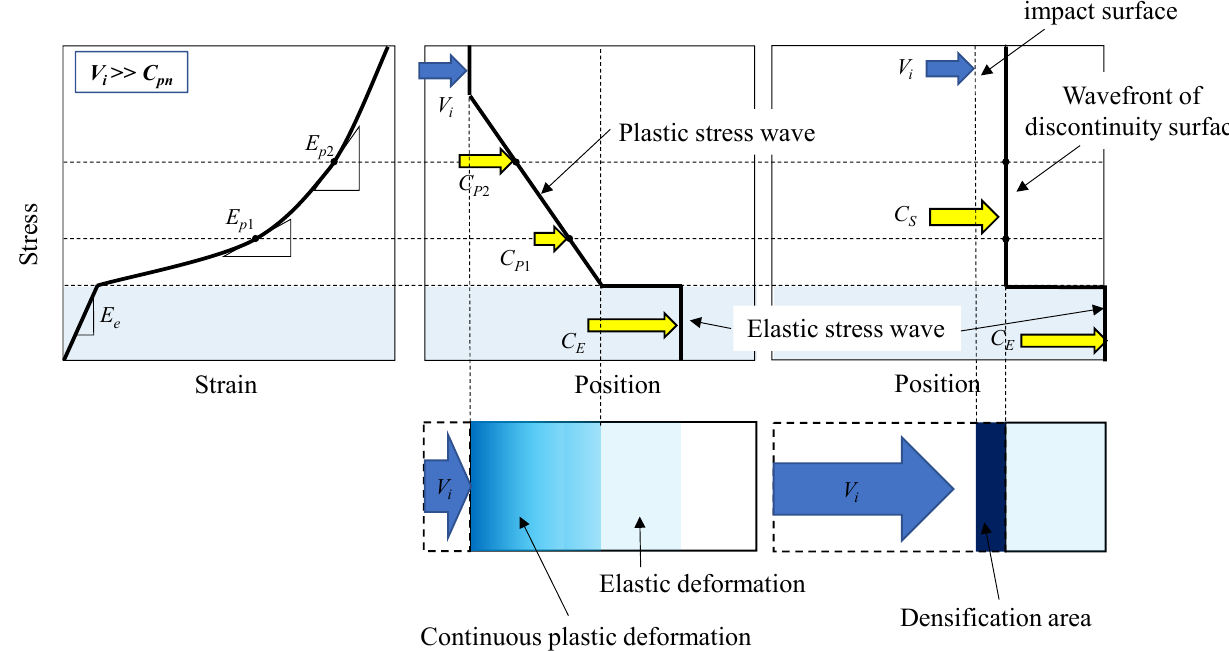
Figure 18. Stress wave propagation behavior when compression velocity is sufficiently higher than plastic stress wave speed.